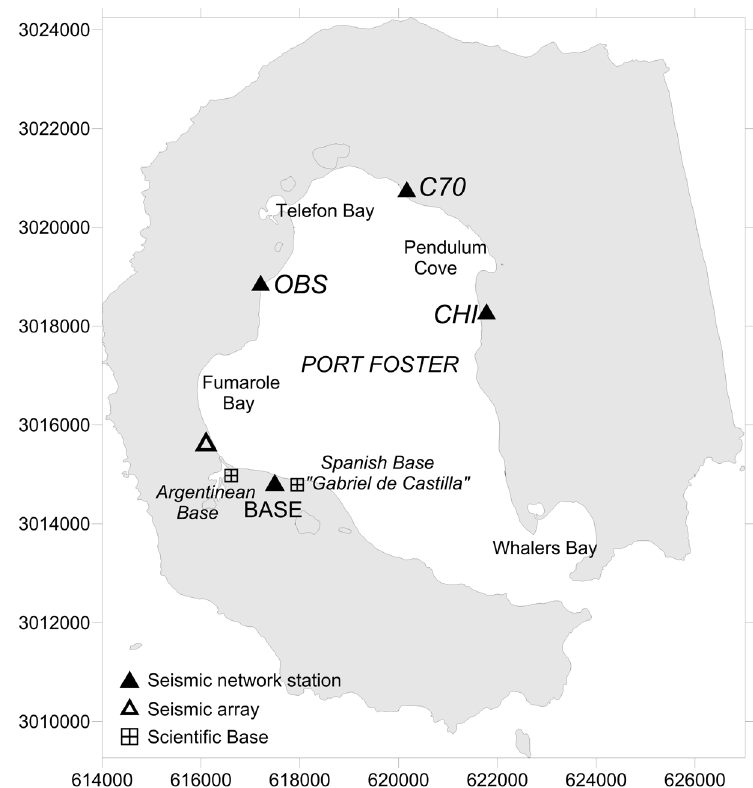
Figure 5. Map of the seismic stations and array used since 2008.